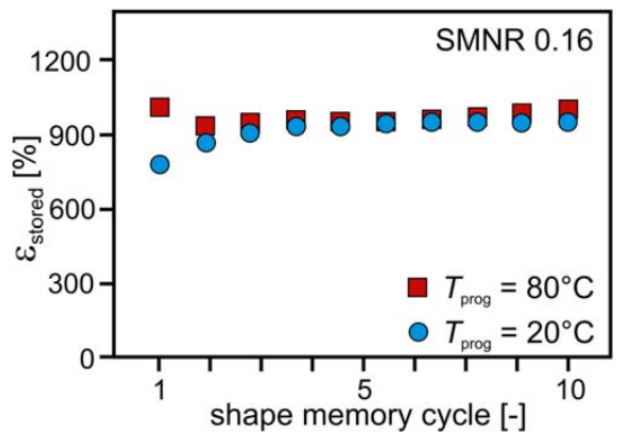
Figure 3. Strain stored for cross-linked SMNR at different programmable temperatures. (Reproduced with permission from [57], Wiley and Sons, 2016).